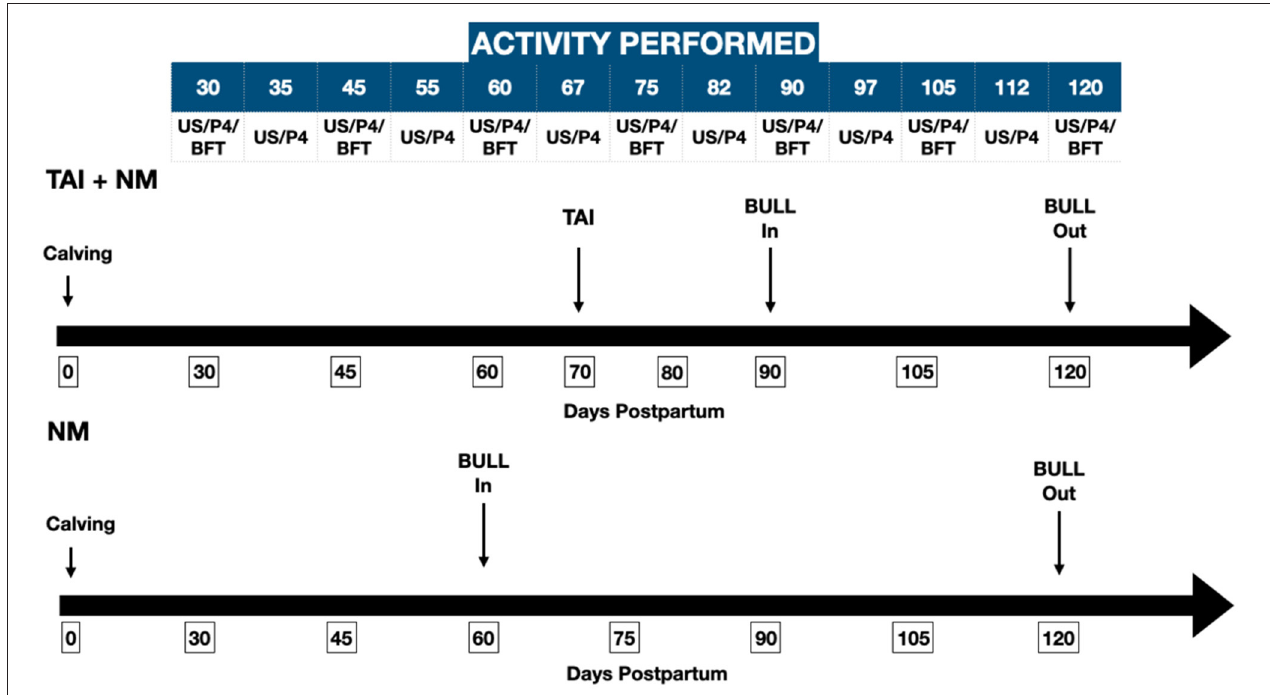
FIGURE 1 | Chronology of the sequence of events and activities performed in TAI + NM (timed artificial insemination followed by natural mating) and NM (natural mating only) breeding programs. TAI, timed artificial insemination; NM, natural mating; US, transrectal ultrasonography; P4, progesterone samples; BFT, backfat